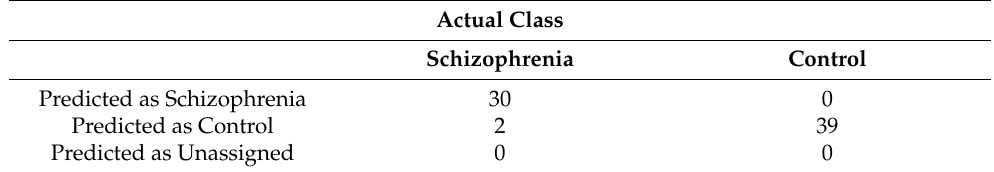
Table 1. Confusion matrix for classification of test data according to PLS-DA model and autoscaling preprocessing.